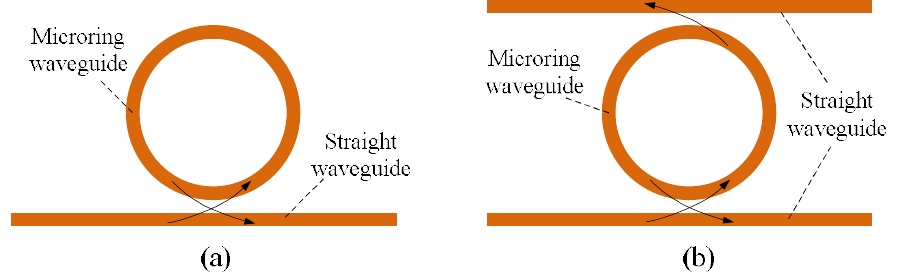
Figure 2. Schematic structures of microring resonators. ( a ) “All-pass” type; ( b ) “add-drop” type.